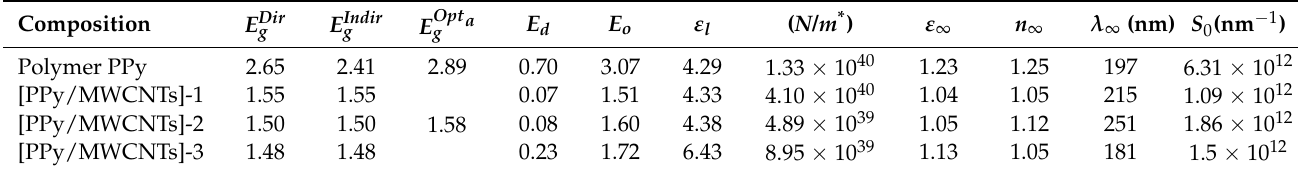
(cid:0) (cid:1) − 1 n 2 − 1 Figure 7. ( a – c ): vs. ( h ν ) 2 , n 2 vs. λ 2 and Figure 7. ( a – c ): (𝑛 (cid:2870) − 1) (cid:2879)(cid:2869) 𝑣𝑠 (ℎ𝜈) (cid:2870) , 𝑛 (cid:2870) 𝑣𝑠 𝜆 (cid:2870) and (𝑛 (cid:2870) − 1) (cid:2879)(cid:2869) 𝑣𝑠 𝜆 (cid:2879)(cid:2870) plots for PPy and different composites as-deposited thin films. types of PPy/MWCNTs composites as-deposited thin films. Table 4. Optical properties of PPy/MWCNTs composites as-deposited thin film; ( E Opt g , E U , ( e 2 (cid:0) (cid:1) λ 2 S 0 = n 2 ∞ − 1 , E d and E o 0